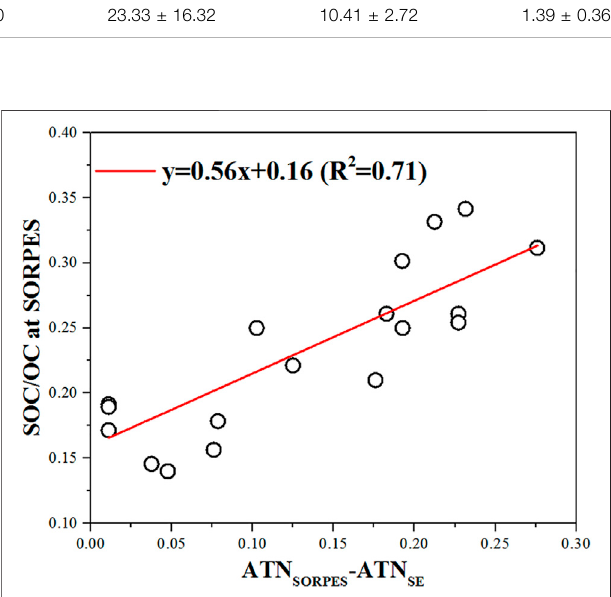
FIGURE 4 | Correlation between the changes in light attenuation (ATN SORPES -ATN SE ) and the ratios of secondary organic carbon (SOC) to organic carbon (OC) (SOC/OC) at the Station for Observing Regional Processes of the Earth System